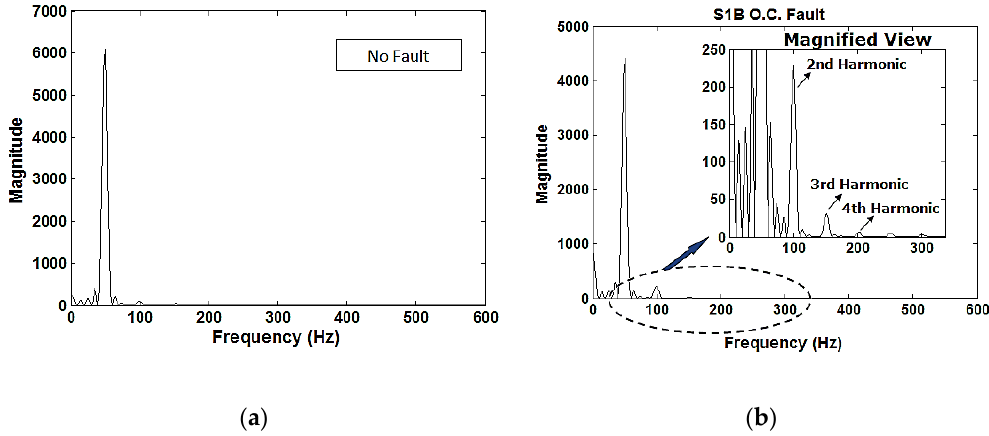
Figure 7. Frequency plot of the output voltage. ( a ) Normal condition; ( b ) S1B open circuit fault.